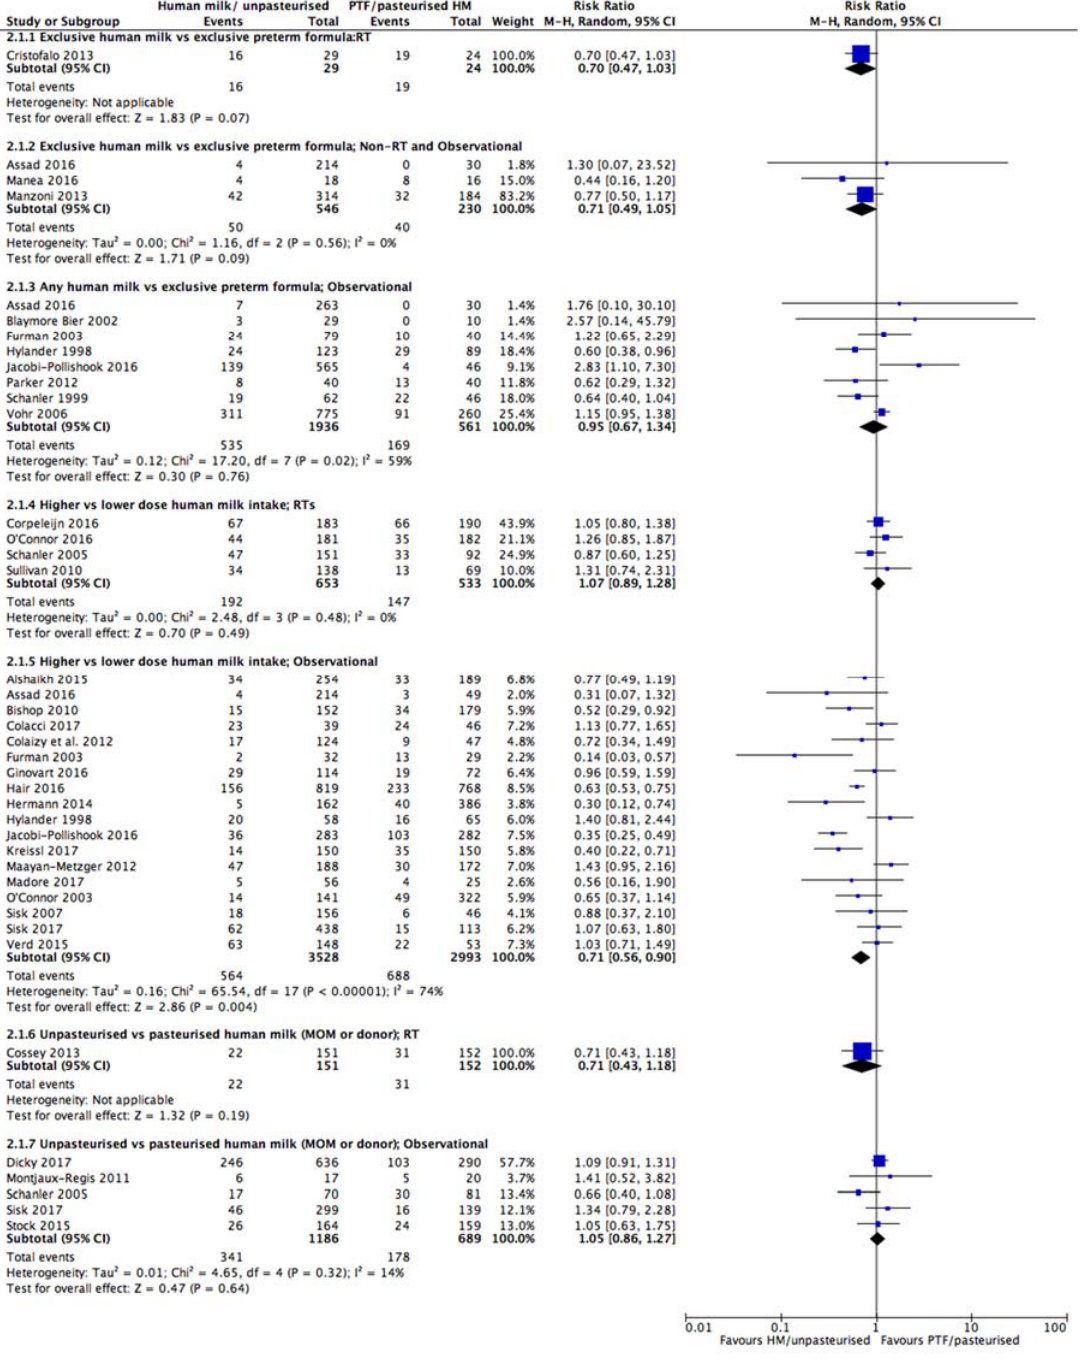
Figure 2. Forest plot of relative risk for the association between human milk and late onset sepsis.